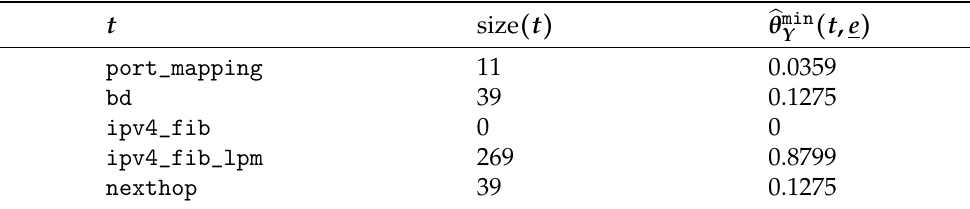
Table A2. Instruction costs of lookup